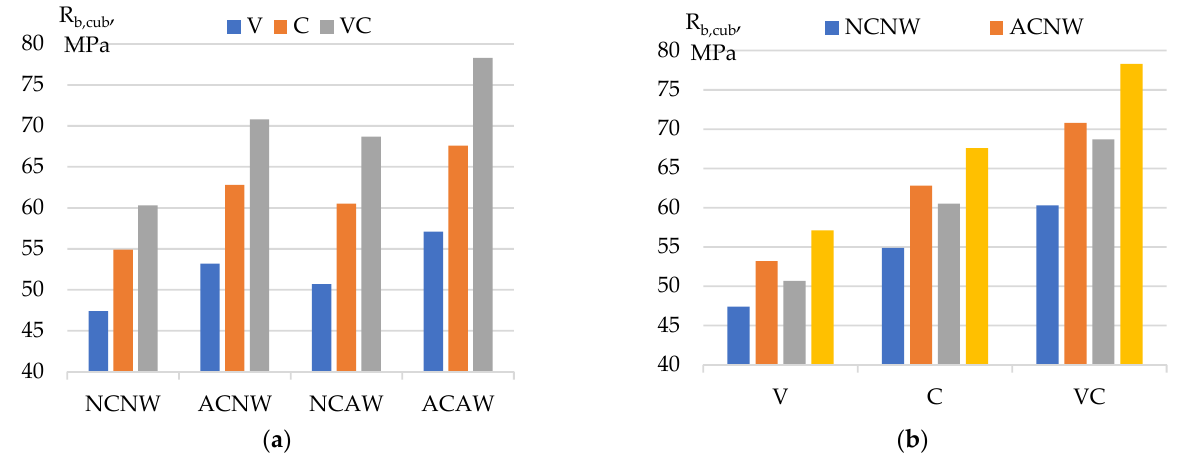
Figure 5. Dependence of the cube strength of concrete: ( a ) on the type of activation, ( b ) on the type of technology for its manufacture.